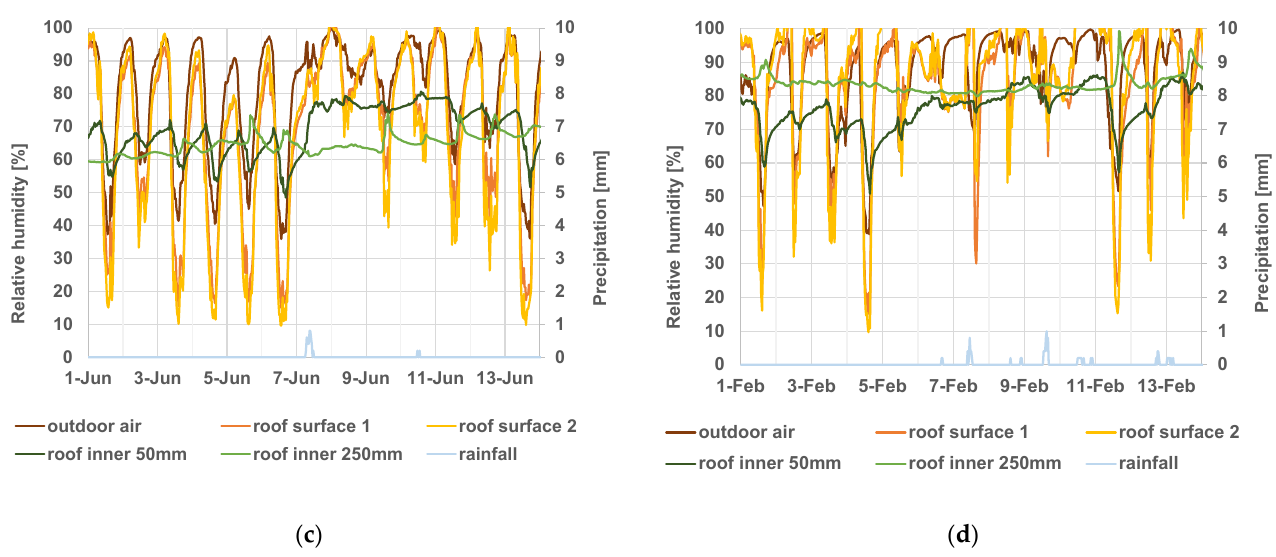
Figure 7. Measured values of temperature ( ◦ C)/relative humidity (%) of thatched roofs from 2019 to 2020. ( a ) Tempera in summer (1–14 June 2019), ( b ) temperature in winter (1–14 February 2020), ( c ) relative humidity in summer (1–14June 2019), and (d) relative humidity in winter (1–14 February 2020), amount of solar radiation is also plotted in figures of temperature (( a , b ) pale orange lines), and the amount of precipitation was also plotted in figures of relative humidity (( c , d ) pale blue lines).